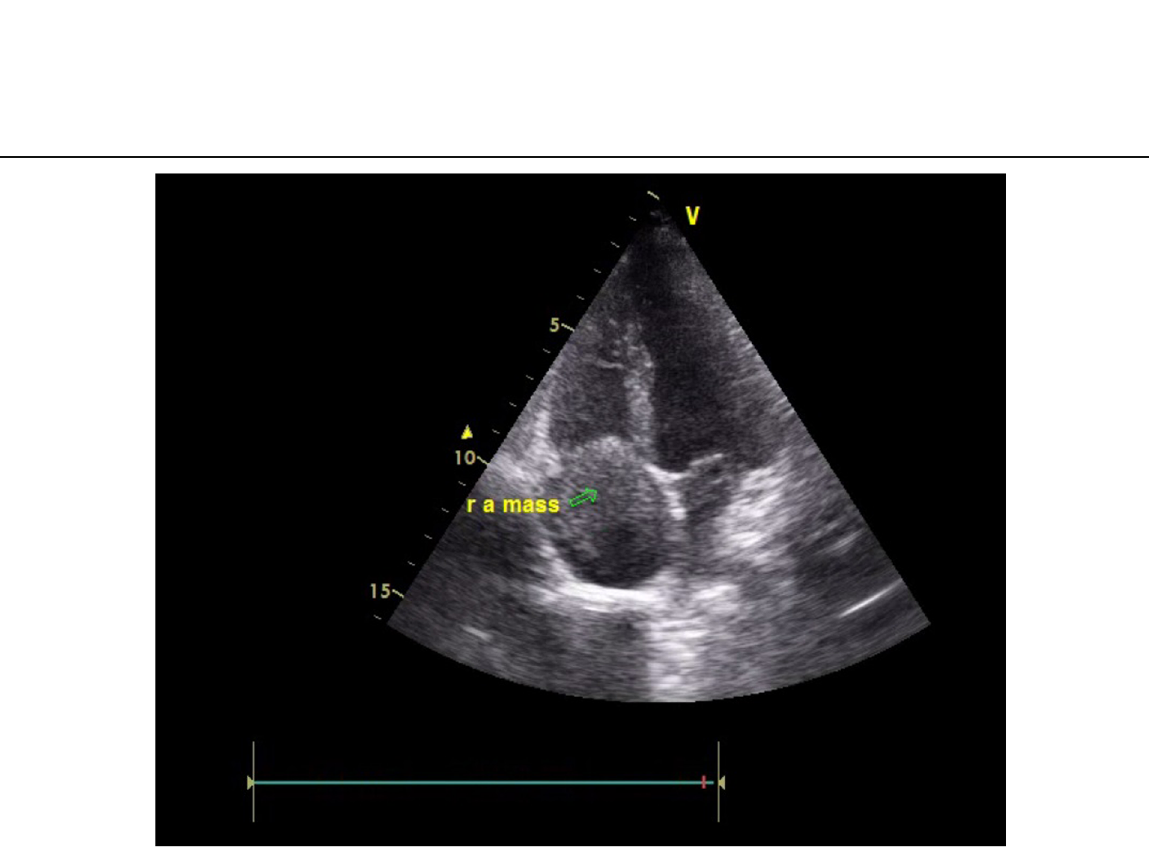
Fig. 2 2D-echocardiographic image showing the rt. atrial mass bulging into the rt. ventricle through the tricuspid